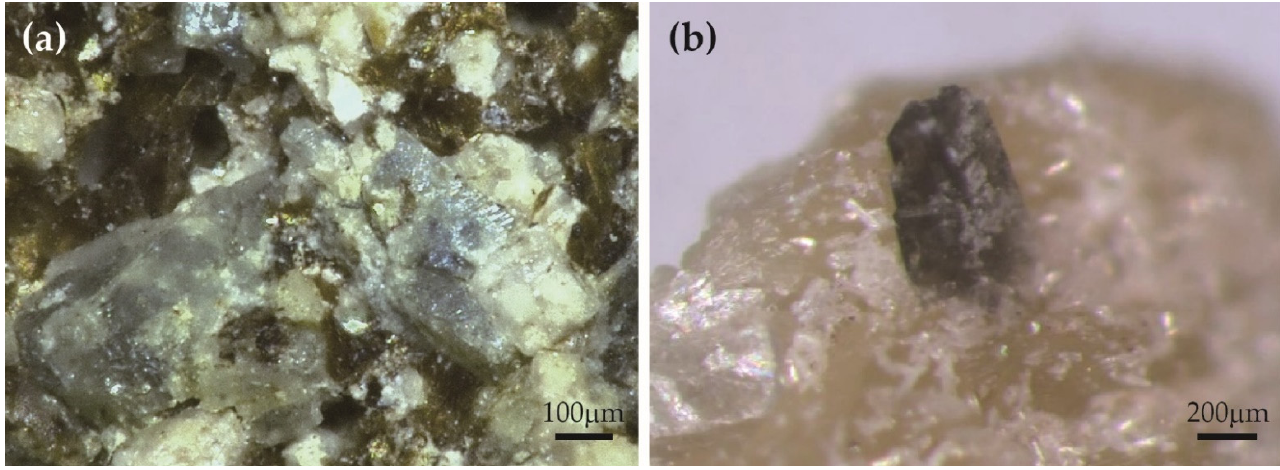
Figure 1. Optical photograph of Sc-rich babingtonite from the Heftetjern pegmatite, Norway ( a ) and the Baveno pegmatite, Italy ( b ).